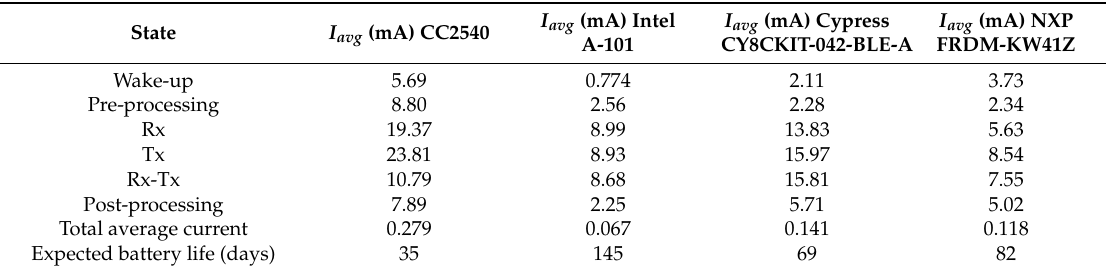
Table 3. Current consumption comparison between the platforms configured as a CD using a connection interval of 100 ms.